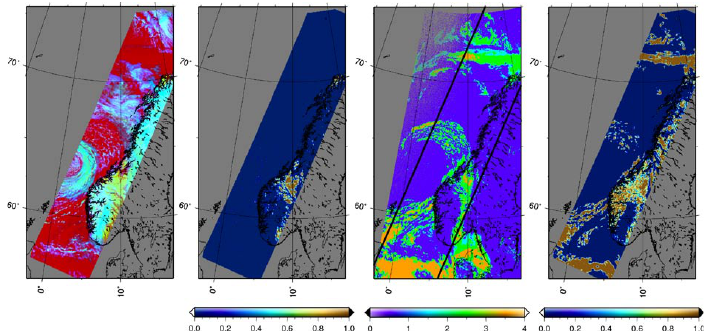
Figure 10. Scandinavian Peninsula, AATSR: 14 April 2006, 10 h 38'17'', orbit number 21547. MODIS: 14 April 2006, 10 h 35'. Left panel is the false color composite (red is 11µm BT, green is 550nm reflectance, blue is 1.6µm reflectance) of initial AATSR scene; second left panel is the clear snow mask of AATSR scene (0 – not snow, 1 – clear snow) achieved with presented method; third left panel is MODIS cloud mask: 1 – cloudy, 2 – probably cloudy, 3 – probably clear, 4 – clear; right panel is operational AATSR cloud mask from level-1b product: 0 – cloudy, 1 – clear.